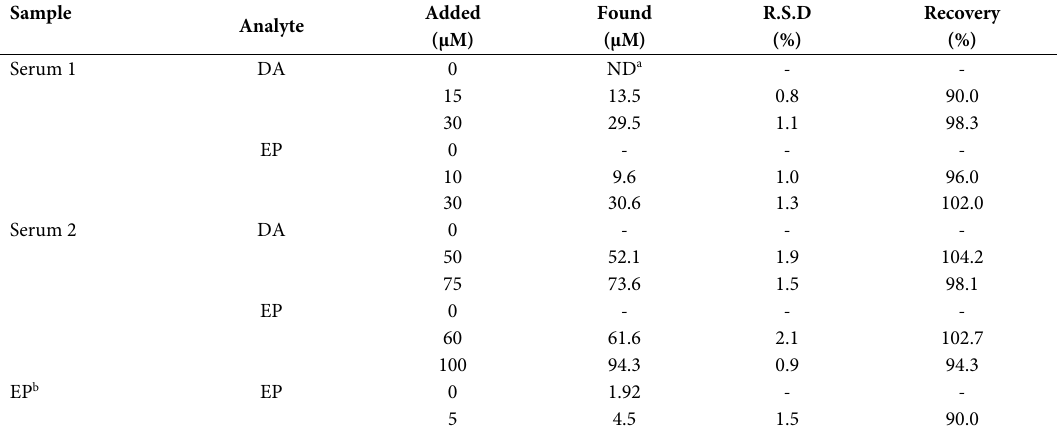
Table 2 Determination of DA and EP in the real samples (n=3) by modified electrode GCE/RGO/TiO 2 Table 2. Determination of DA and EP in the pharmaceutical products (n=4) by modified electrode GCE/RGO/TiO Sample